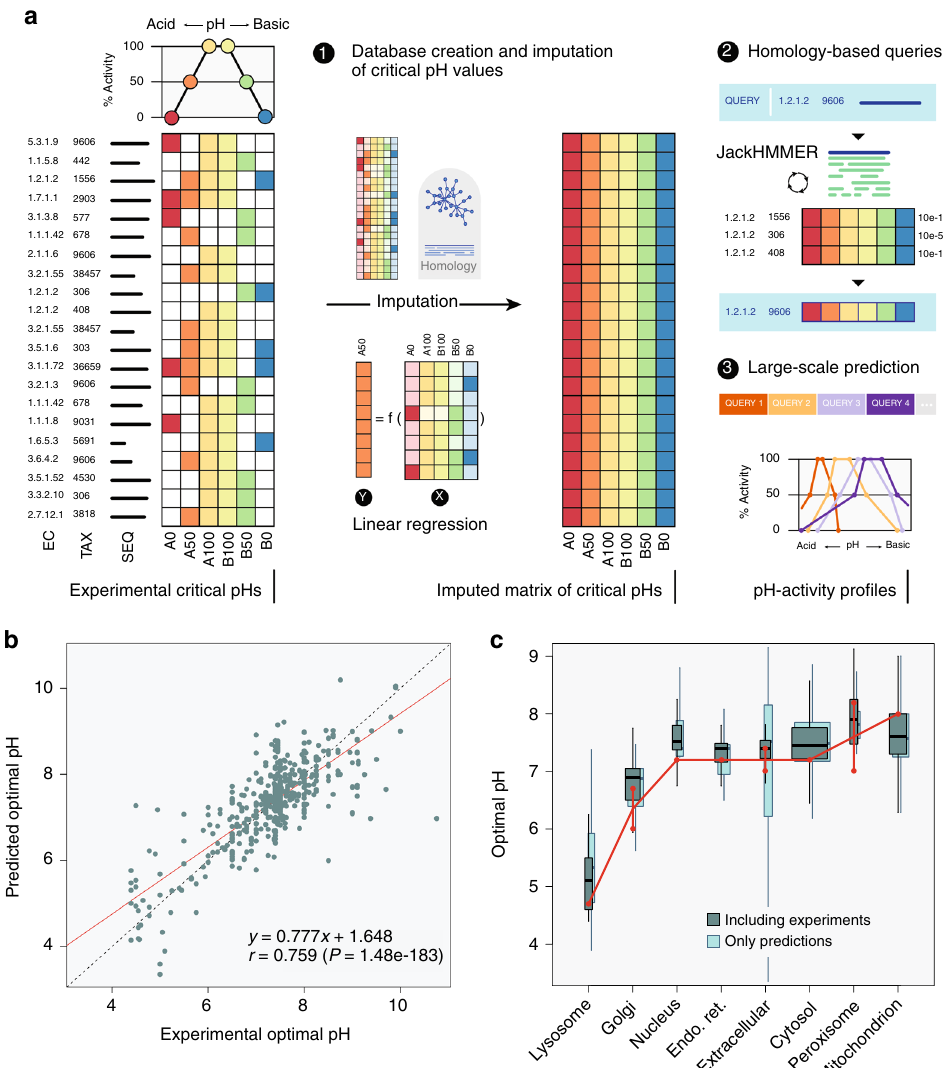
Fig. 1 Reconstruction of enzymatic pH-dependent activity pro fi les. a Six critical pH points, corresponding to the 0%, 50%, and 100% of enzymatic activity at the acidic and basic regimes were extracted from BRENDA from all taxa. Missing data was complemented with existing data from close homologs or were predicted using linear regressors, generating an imputed database of pH-activity pro fi les, from which one infers the pH-pro fi le of any enzyme (Methods, Supplementary Methods and Supplementary Figures 1 – 7 for a complete description). b Predicted vs. experimental pH optima, de fi ned as the average of the critical points A100 and B100. The red line depicts linear regression. c Distributions of the pH optima of metabolic enzymes in each cellular compartment. Box widths are proportional to the number of enzymes in each compartment. Each box delineates lower quartile, median, and upper quartile values. Most extreme values (whiskers) are within 1.5 times the inter-quartile range from the ends of the box. Red dots depict the measured physiological pHi range of the compartment. “ Including experiments ” boxes correspond to the pH optima that were used in the subsequent GSMM modeling. As a validation, we include “ Only predictions ” boxplots, which are the result of the 10-fold cross-validation (Supplementary Figure